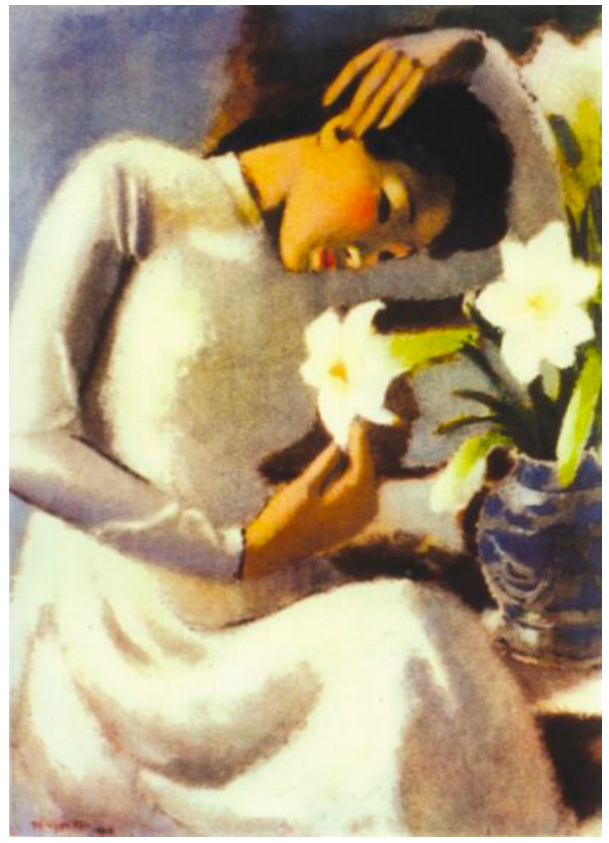
Figure 1. Thieu nu ben hoa hue (Young woman with Lily)—To Ngoc Van. The image was sourced from website CINET.VN (NLH 2014).